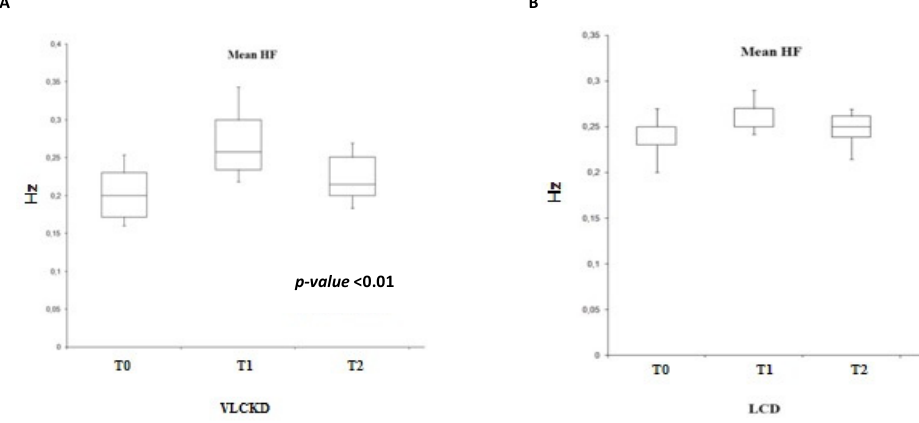
Figure 4. Variability of the mean HF in VLCKD subjects ( A ) and in LCD subjects ( B ).